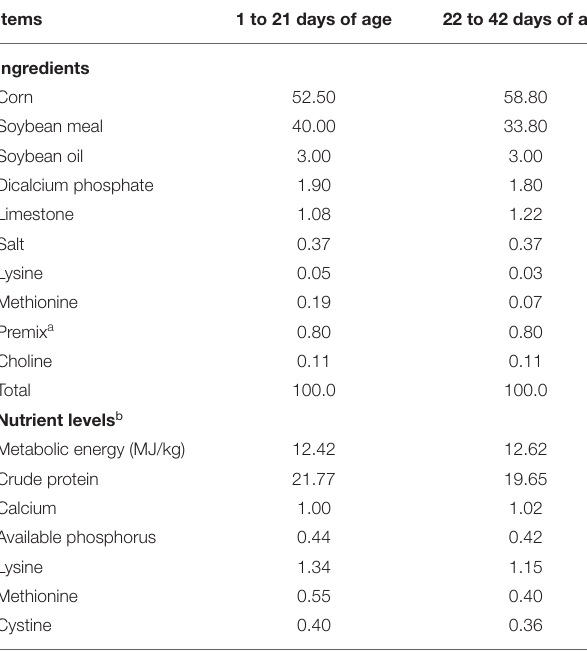
TABLE 1 | Composition and nutrient levels of the basal diet (as-fed basis), %. Items